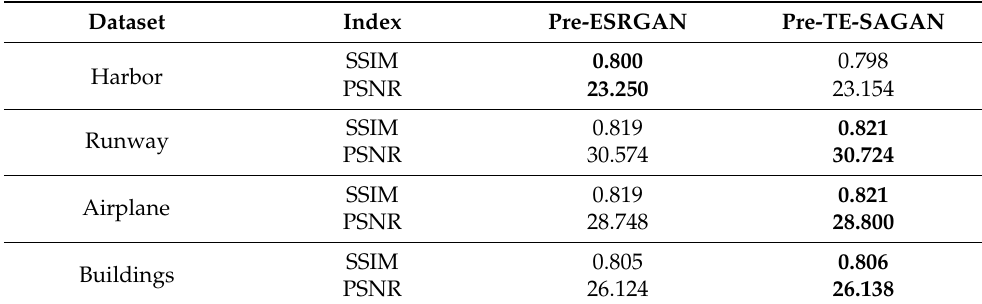
Table 1. Comparison of pre-ESRGAN and Pre-TE-SAGAN using part of the UC Merced Land Use dataset.